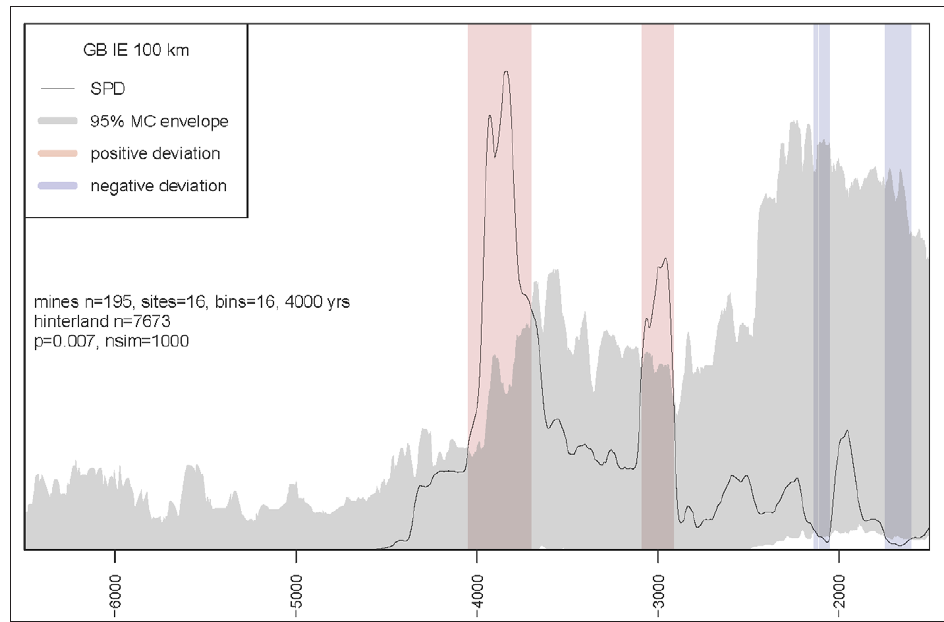
Figure 2: As figure 1 but with only one date per mine or quarry. This is achieved by grouping the dates into 4000 year bins. The overall significance of the departures =